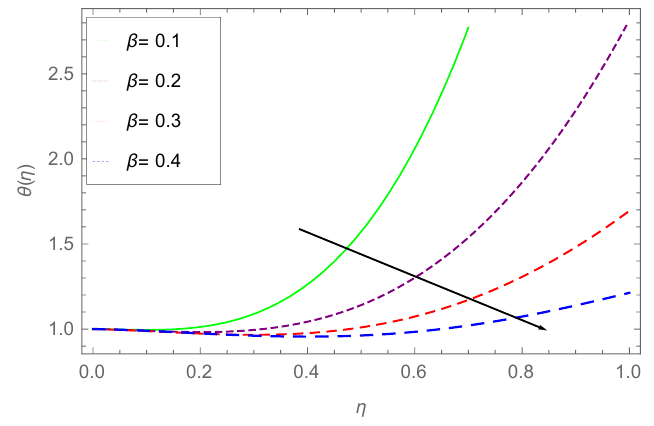
Figure 11. Impact of β on θ ( η ) , for St = 0.1, Nt = 0.5, Rd = 0.6, Nb =